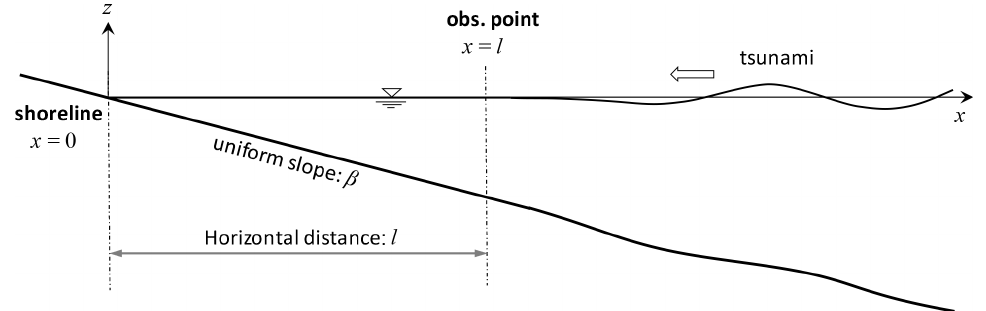
Figure 1. Schematic illustration of the boundary value